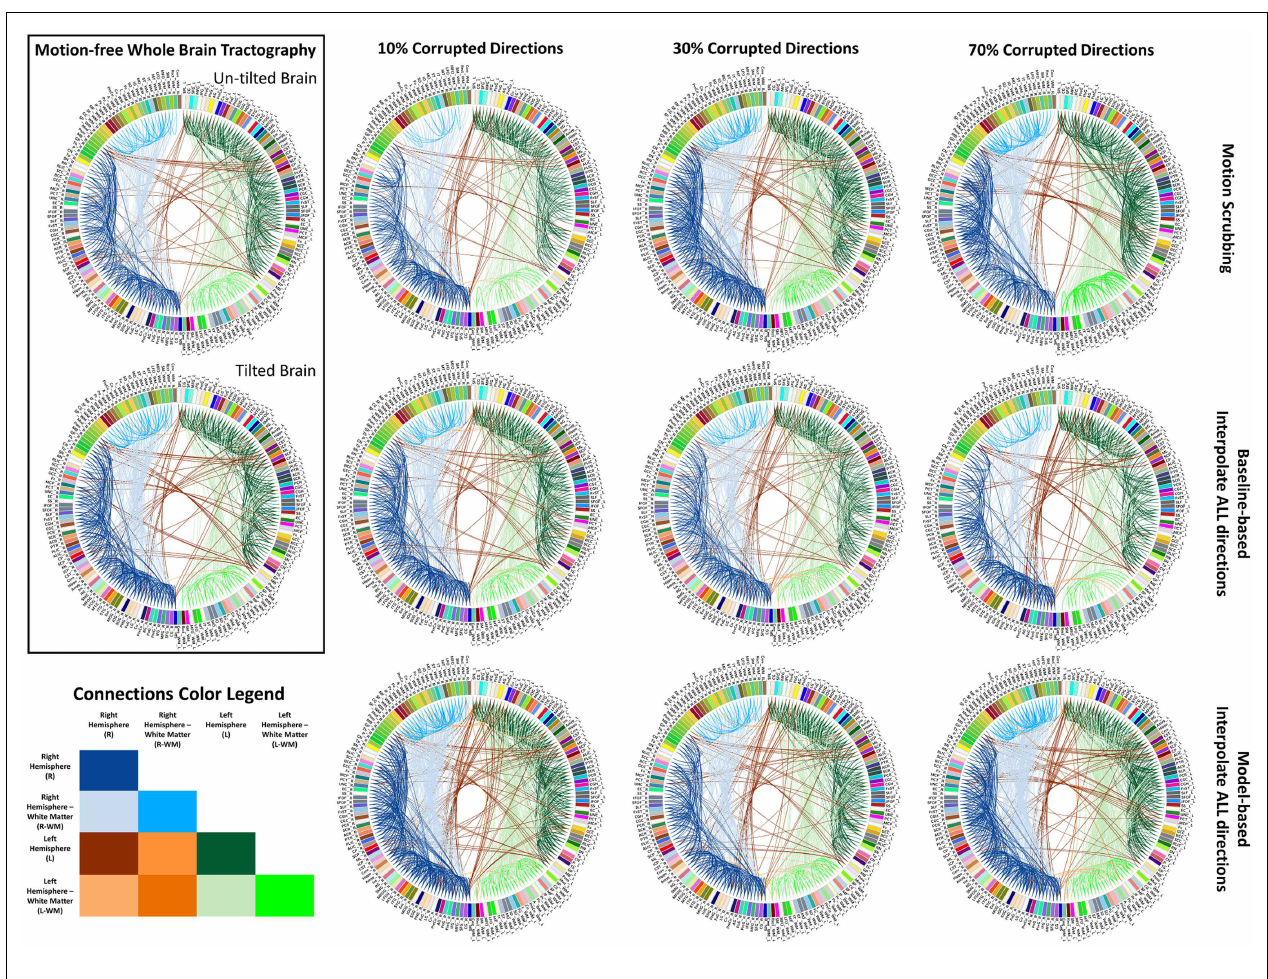
outlier-based (i.e., motion scrubbing) and registration-based (using baseline and model-based reference volumes). Notice the tendency of motion scrubbing to add more links between nearby ROIs at corruption percentages, implying the detection of more short